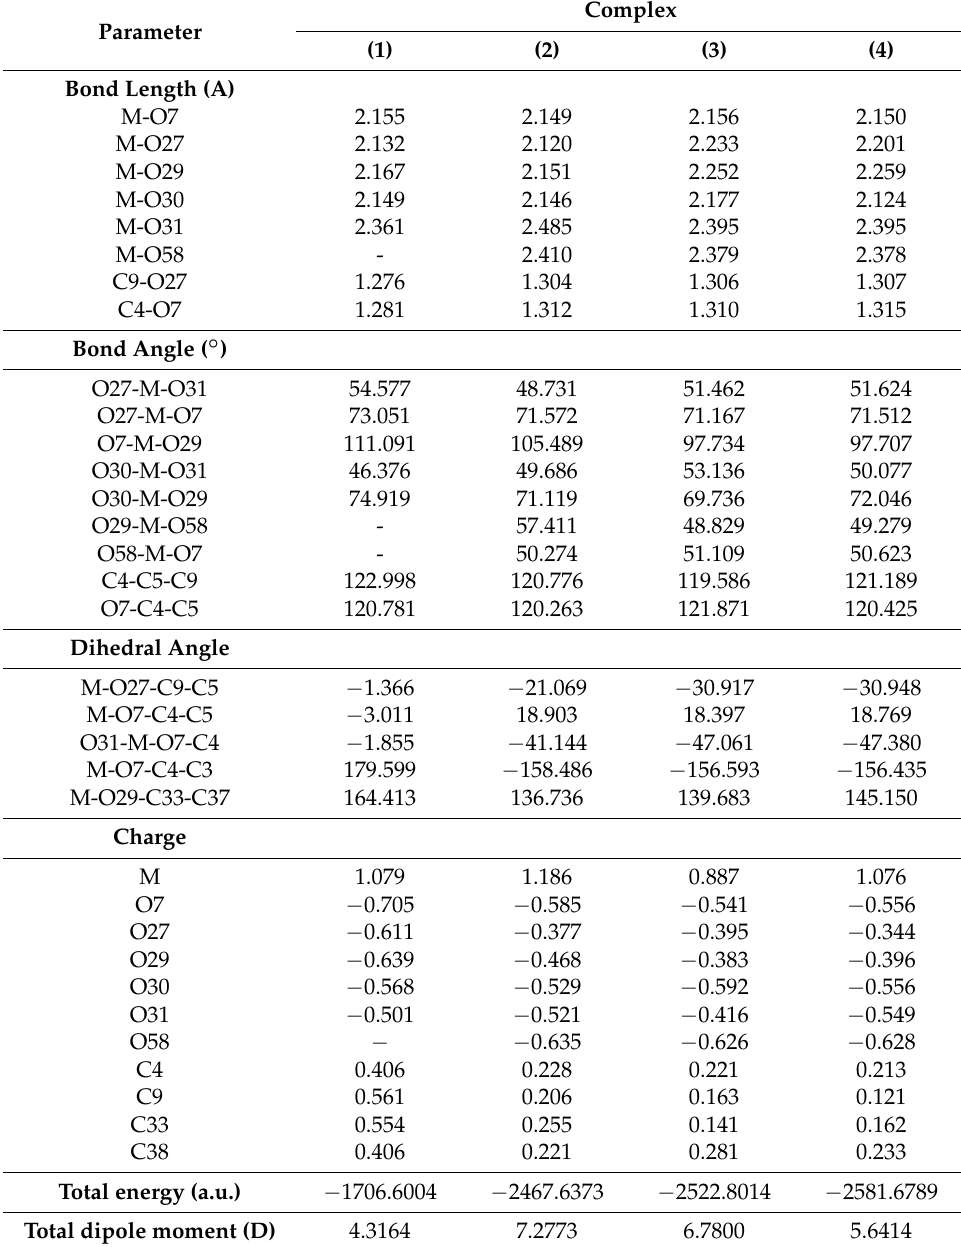
Table 3. Geometric parameters bond lengths (A), angles ( ◦ ), charge density, total energy and total dipole moment of complexes ( 1 )–( 4 ) as resulted from DFT